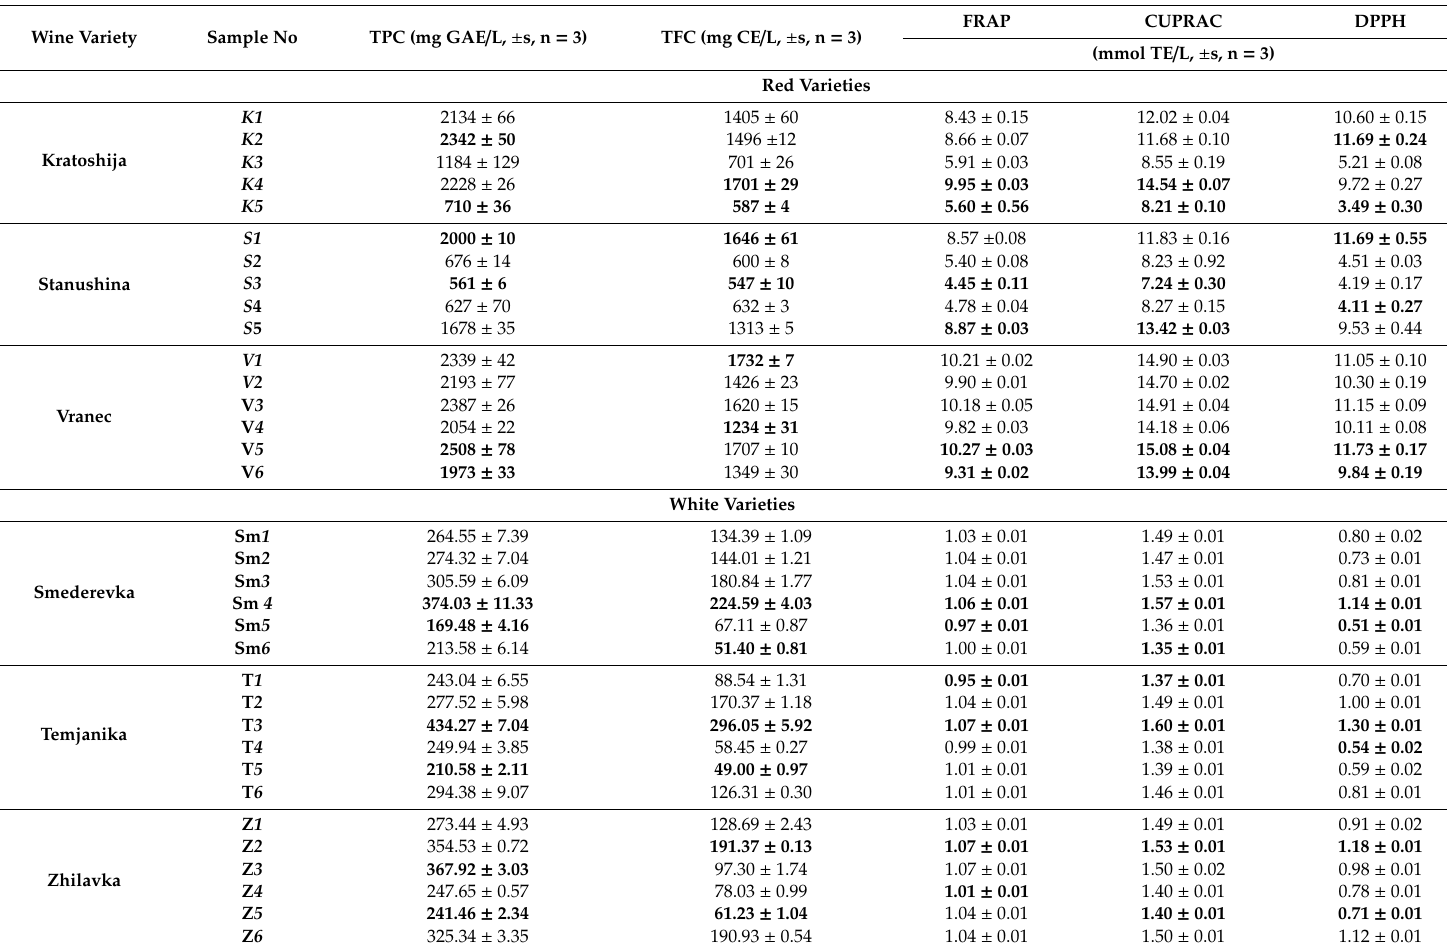
Table 1. Total phenolic content (TPC), total flavonoid content (TFC) and antioxidant activity by FRAP (ferric-reducing antioxidant power), CUPRAC (cupric ion-reducing antioxidant capacity) and DPPH (2,2-diphenyl-1-picrylhydrazyl) assays of red and white varieties (the lowest and the highest values within each variety are shown in bold)